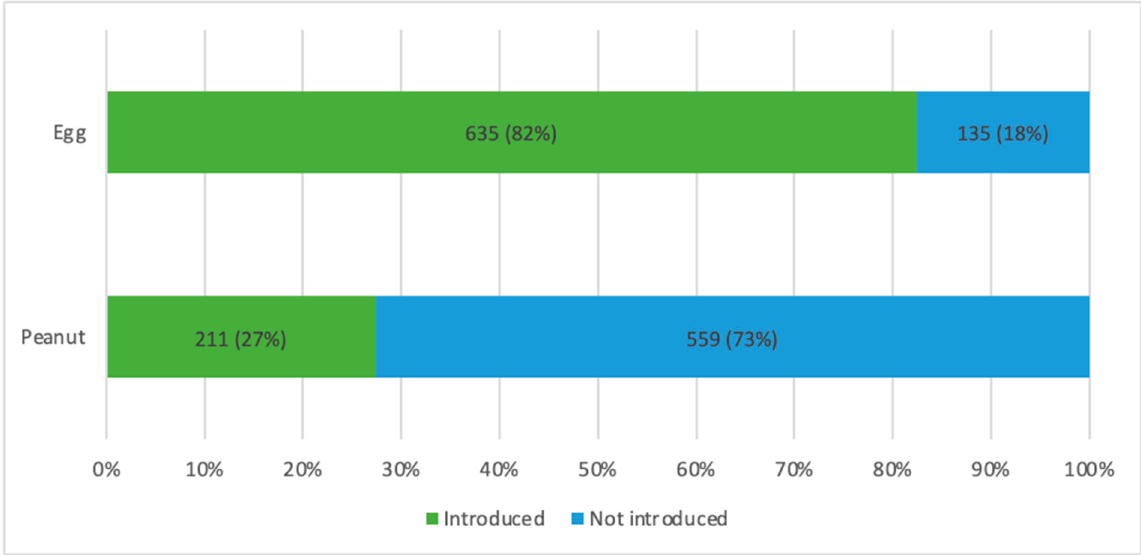
Figure 1. Introduction of egg and peanut at age 12 months. Bar graph depicting the number and percentage of participants with early introduc- tion of egg as defined by parent report of egg product consumption at least once per week at age 12 months vs. those without (top bar) as well as the number and percentage of participants with early introduction of peanut as defined by parent report of peanut prod- uct consumption at least once per week at age 12 months vs. those without (bottom bar). duction are depicted by blue bars.